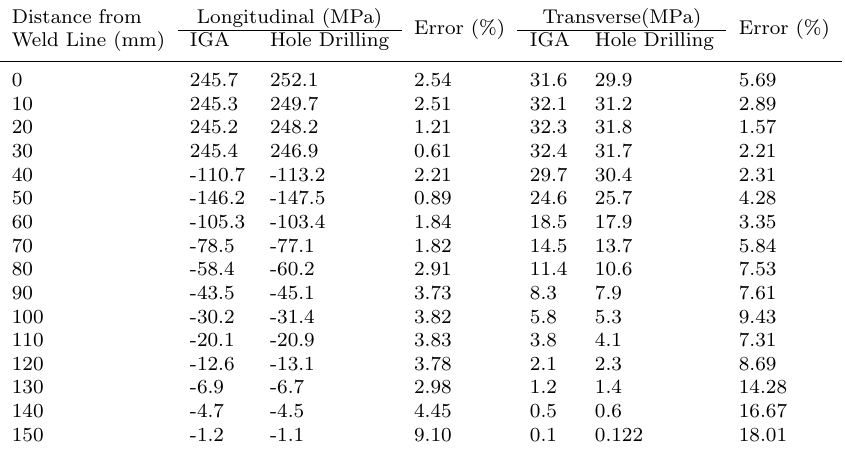
Transverse(MPa) Error (%) Error (%)